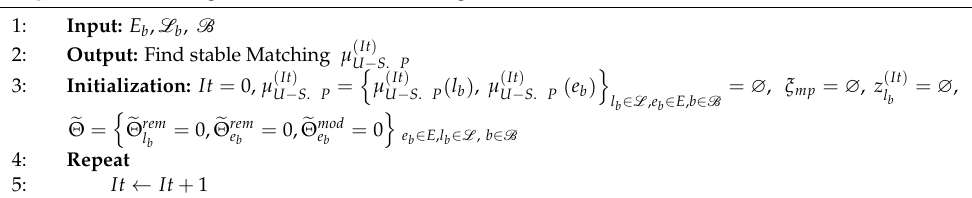
Algorithm 2: Matching Game for User-Slice Pairing